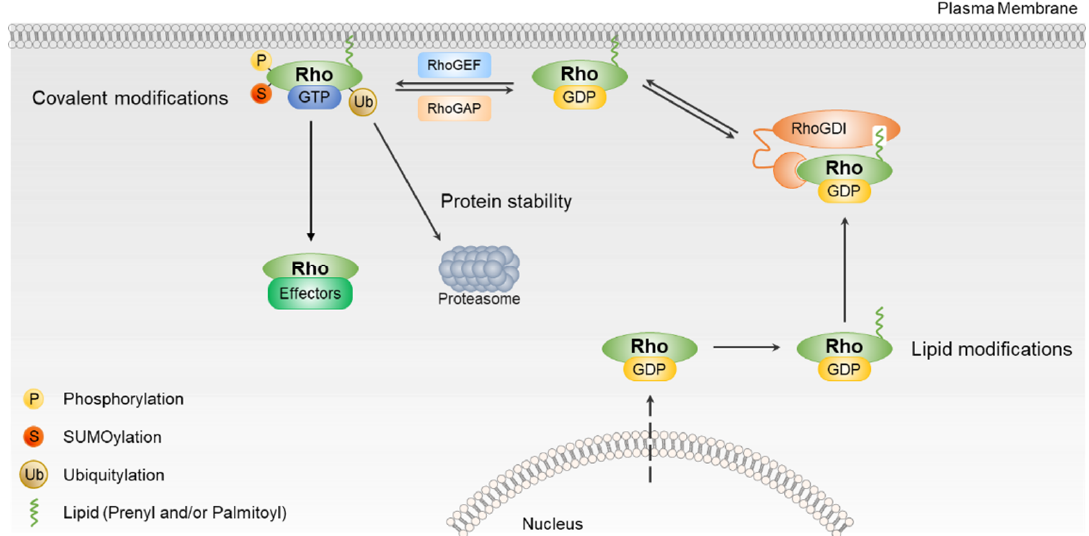
Figure 1. Guanosine diphosphate (GDP)-guanosine triphosphate (GTP) exchange cycle of Rho